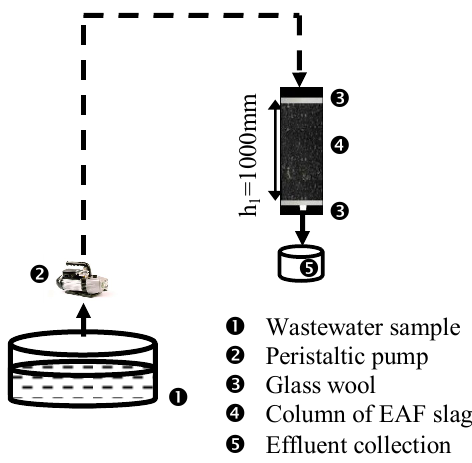
Figure 2. Schematic Drawing of the EAFS Column.